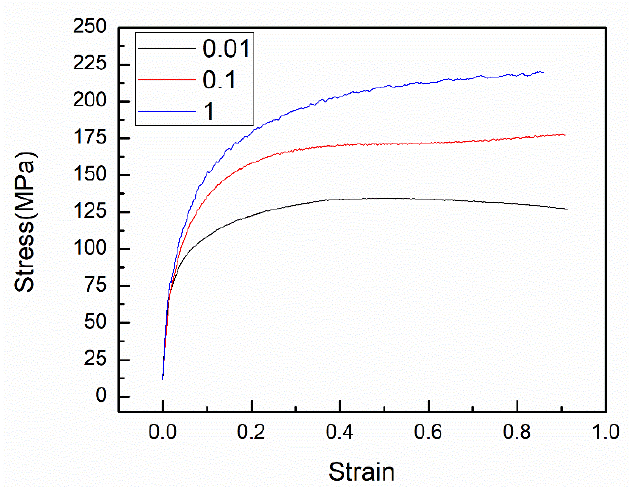
Figure 16. The true stress–strain curves for the low-carbon ferritic stainless steel samples with the di ff erent strain different strain rates.